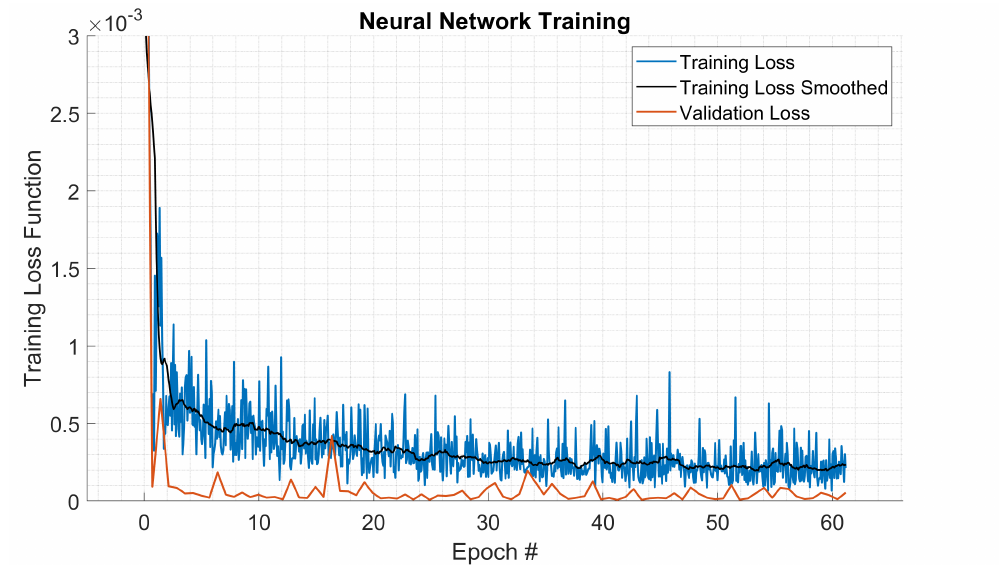
Figure 13. Training process along the epochs of Bi-LSTM related to the best SOC range.